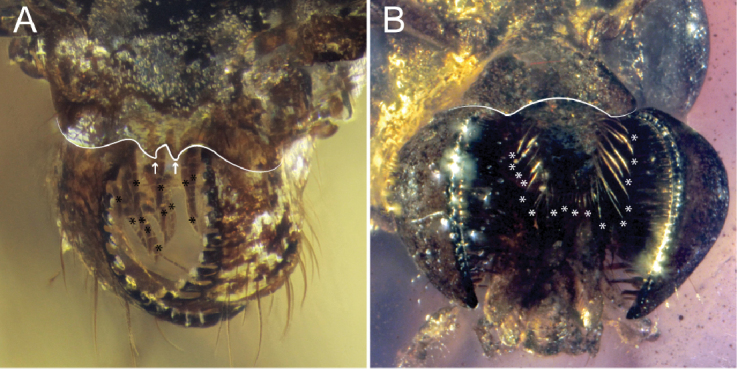
Mouthparts of †Camelomecia clade genera A †Camelosphecia
fossor gen. et sp. nov. holotype female, dorsolateral oblique (ANTWEB1038930) B †Camelomecia
janovitzi holotype female, anterolateral oblique (AMNH-BUTJ003, AntWeb: Phil Barden).